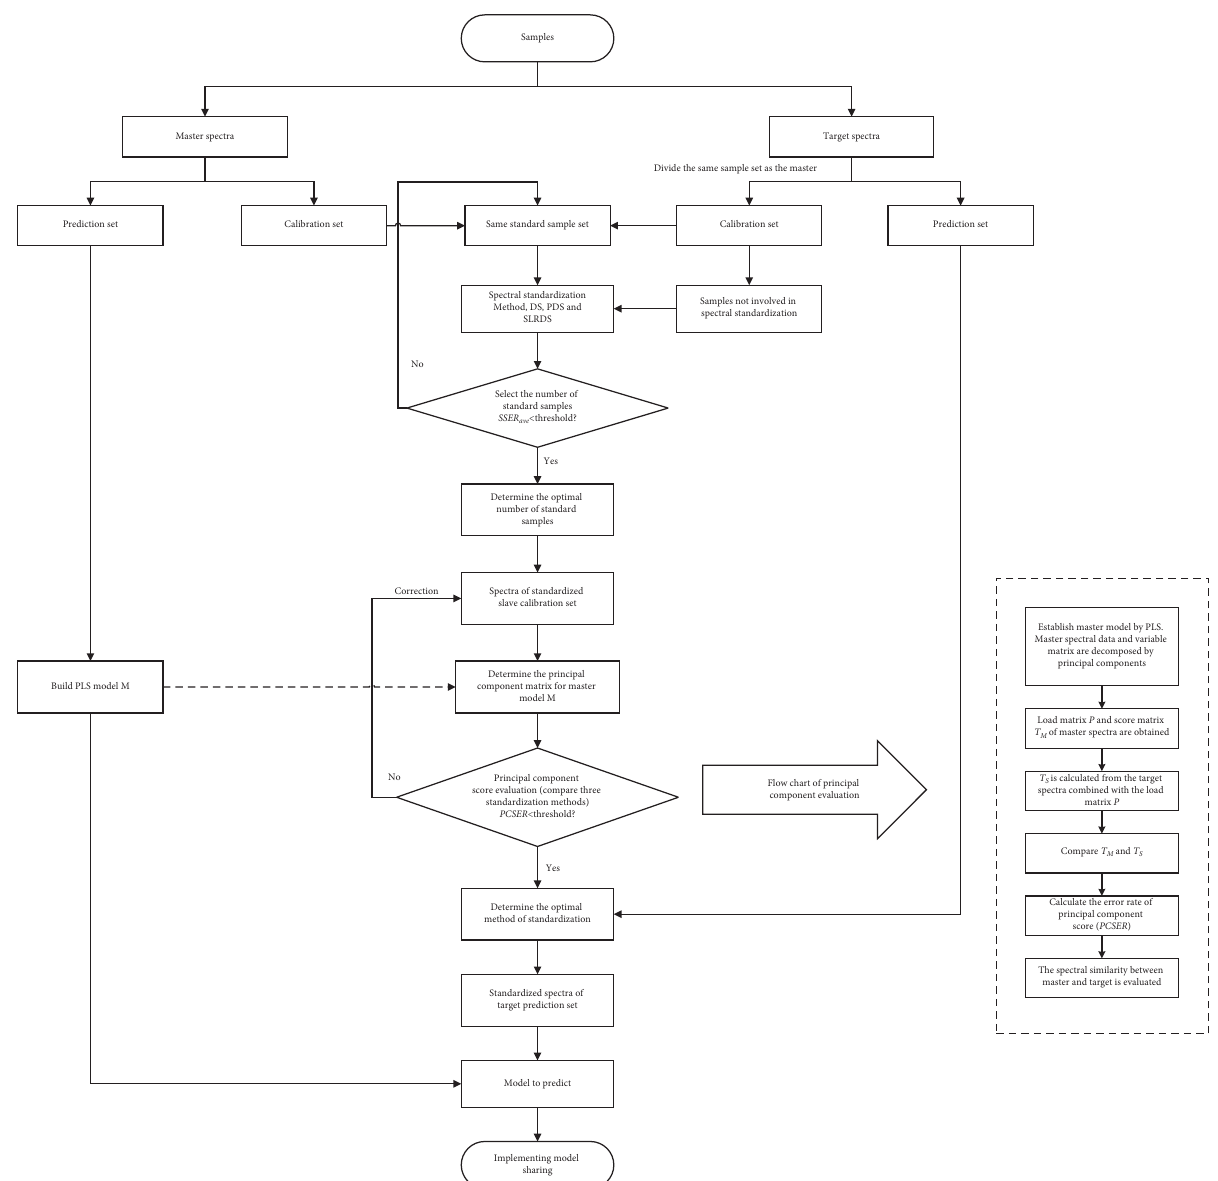
Figure 1: The flow chart of model sharing based on principal component score